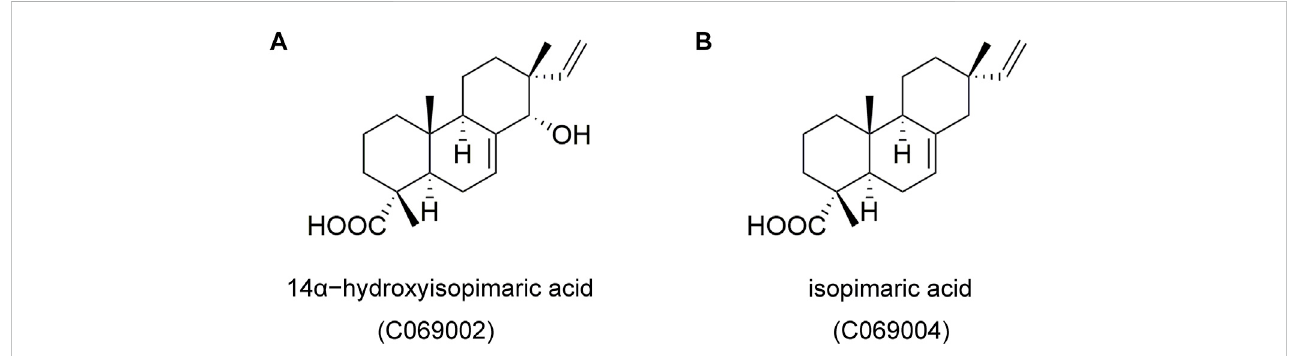
Chemical structures of two isolated compounds, 14 α -hydroxyisopimaric acid (C069002) (A) and isopimaric acid (C069004) (B) , from the fl owers of the Callicarpa rubella